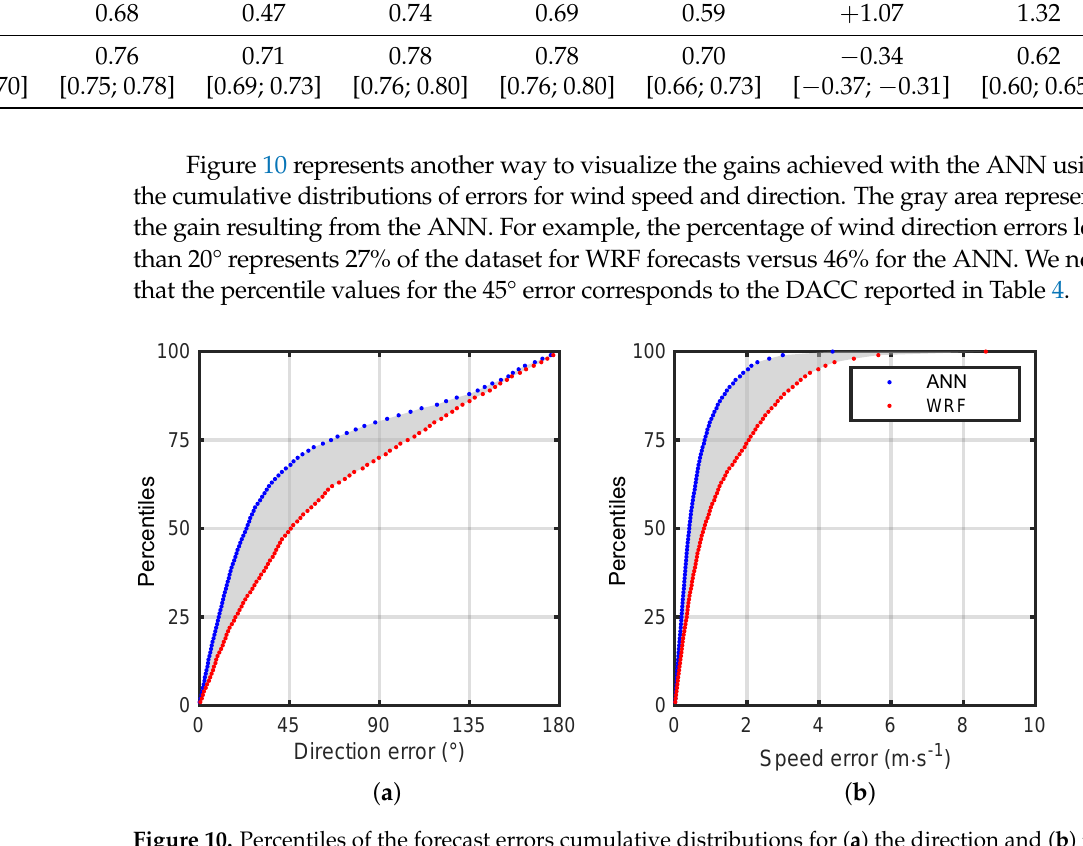
Figure 10. Percentiles of the forecast errors cumulative distributions for ( a ) the direction and ( b ) the speed of the wind at 2m. WRF results are in red and ANN results are in blue. Two regions are identified in the cumulative distribution of direction errors. For errors the differences between the two distributions are small. That means that the ANN is not